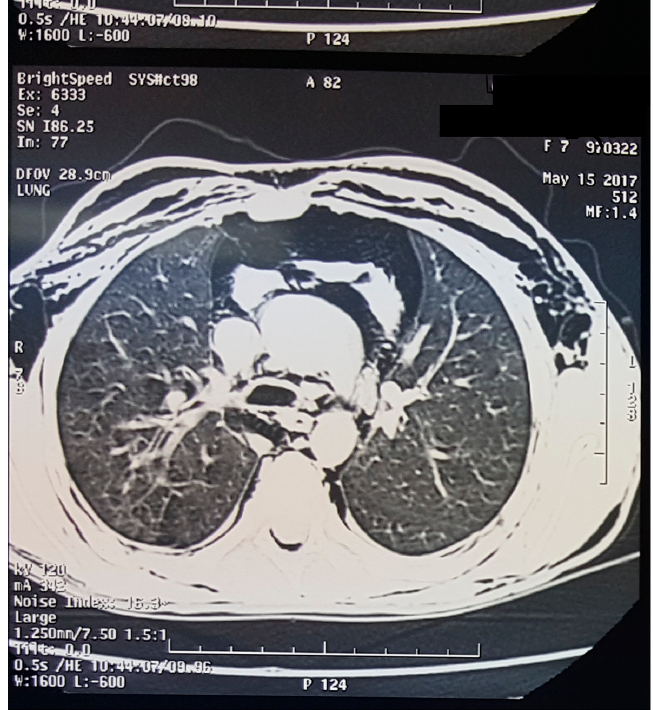
Figure 2. Computed tomography (CT) scan showing pneumomediastinum, pneumopericardium and emphysema.